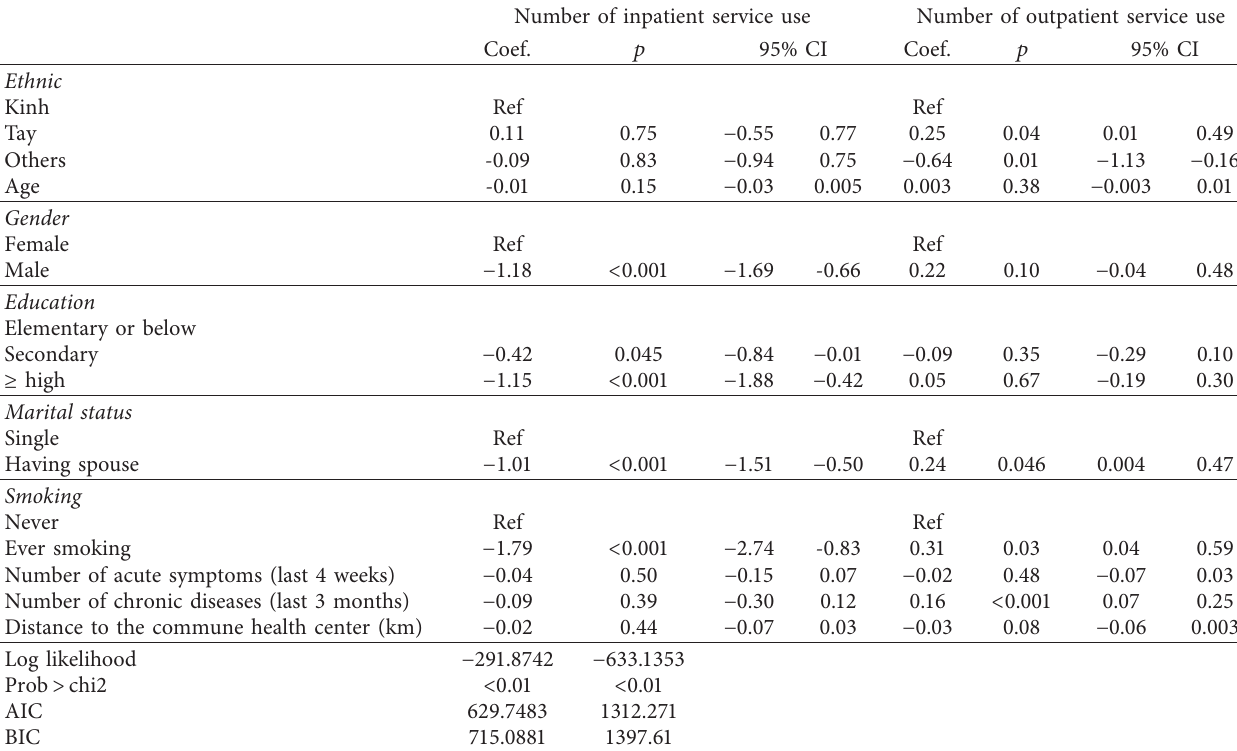
Table 4: Factors associated with health service